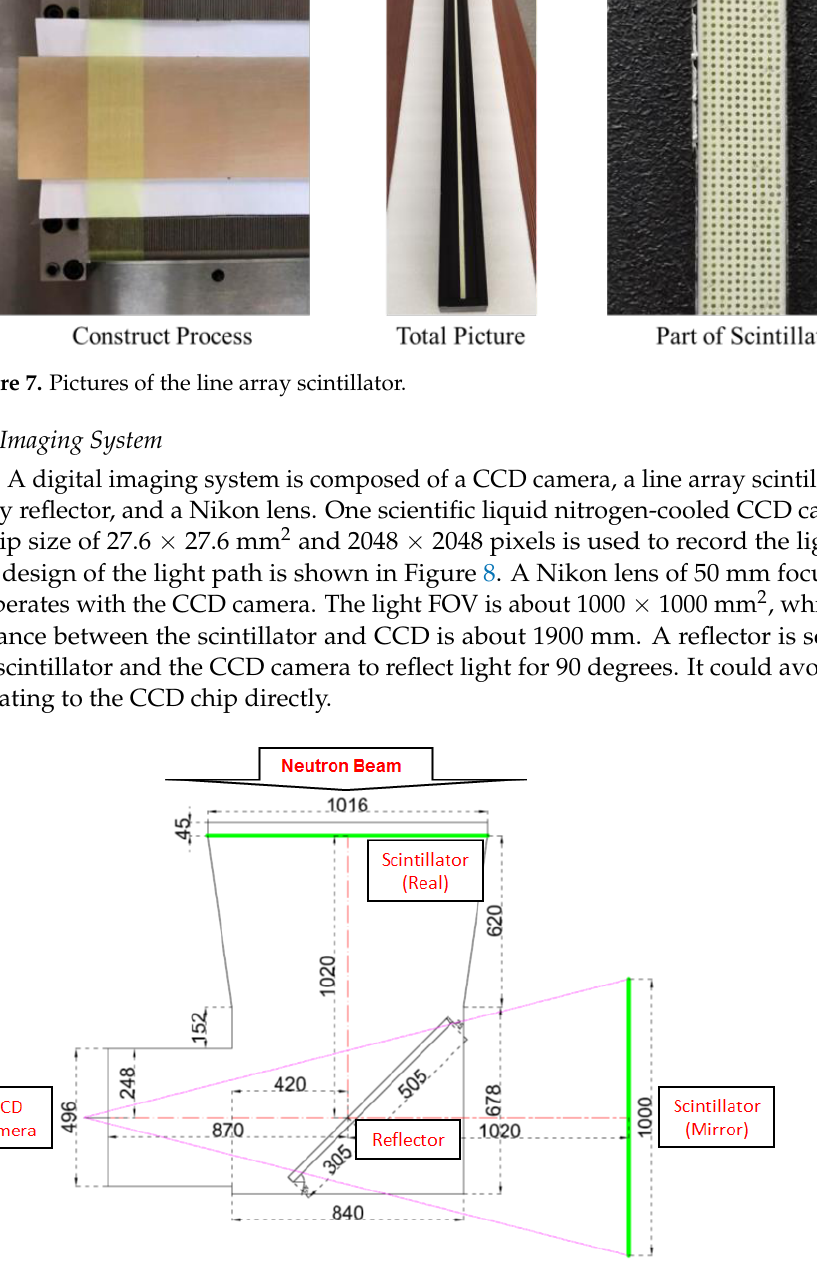
Figure 8. Overhead view of the light path. The green lines indicate the real image and the mirror image.The imaging system is covered by a dark case, which is composed of aluminum, boron polyethylene, and lead materials. Its inner height is 300 mm. The sketch map is shown in Figure